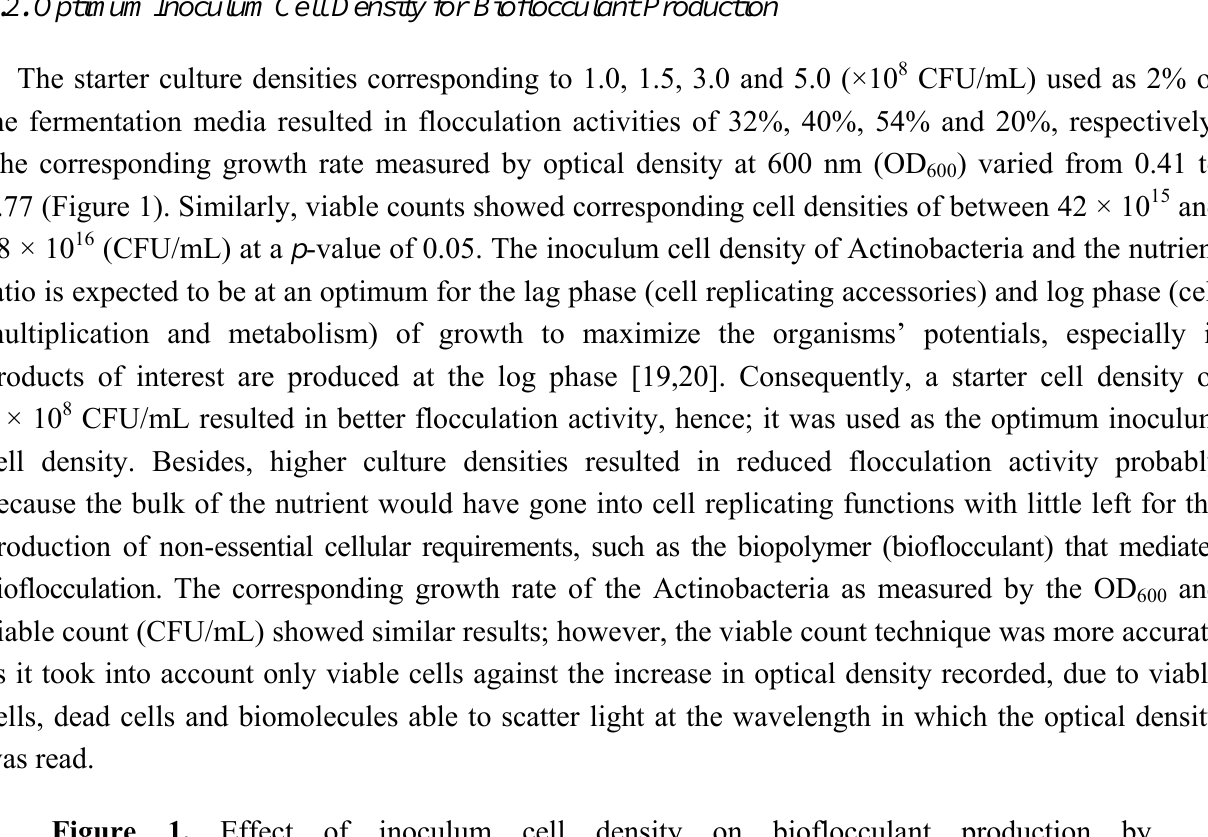
Figure 1. Effect of inoculum cell density on bioflocculant production by Brachybacterium sp.